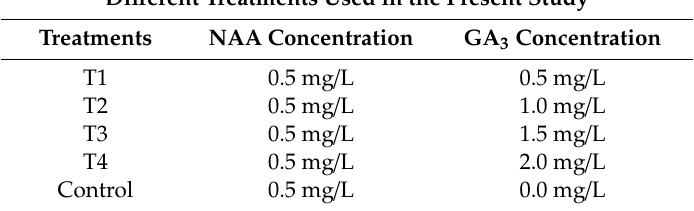
Table 1. Di ff erent concentrations of gibberellic acid (GA 3 ) applied for biomass accumulation and secondary metabolites production in adventitious root cultures of Stevia rebaudiana . Di ff erent Treatments Used in the Present